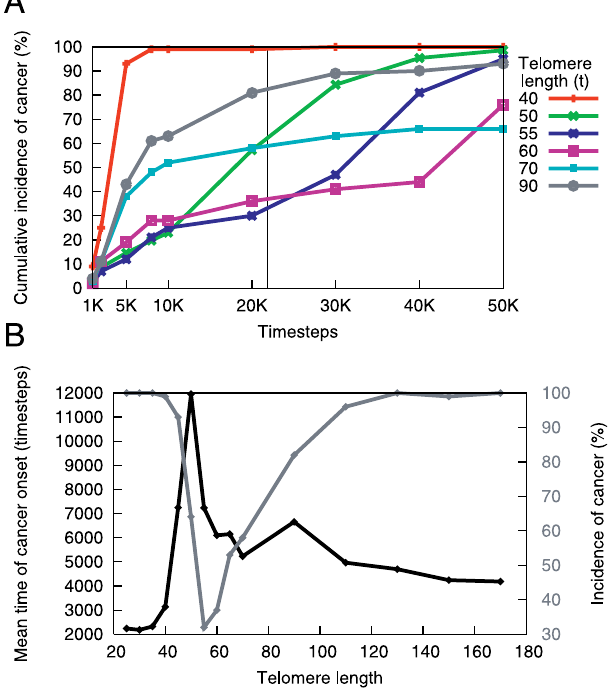
Figure 4. Initial Telomere Length Affects Incidence and Onset of Cancer (A) Initial telomere length affects the pattern of incidence across time. Each point in time on the x -axis represents the cumulative incidence of cancers that arose before that time. The initial telomere length governs the tradeoff between the incidence of early and late cancer onset. Short (40 units) and long (90 units) telomeres produce an earlier, higher incidence of cancer than do telomeres of intermediate length. (B) Mean onset time and incidence for cancers acquired before 21,900 time steps as a function of initial telomere length. This subfigure represents a snapshot at time t ¼ 21,900, indicated by the vertical black line in (A). Note that the gray curve corresponds to the secondary y -axis. DOI: